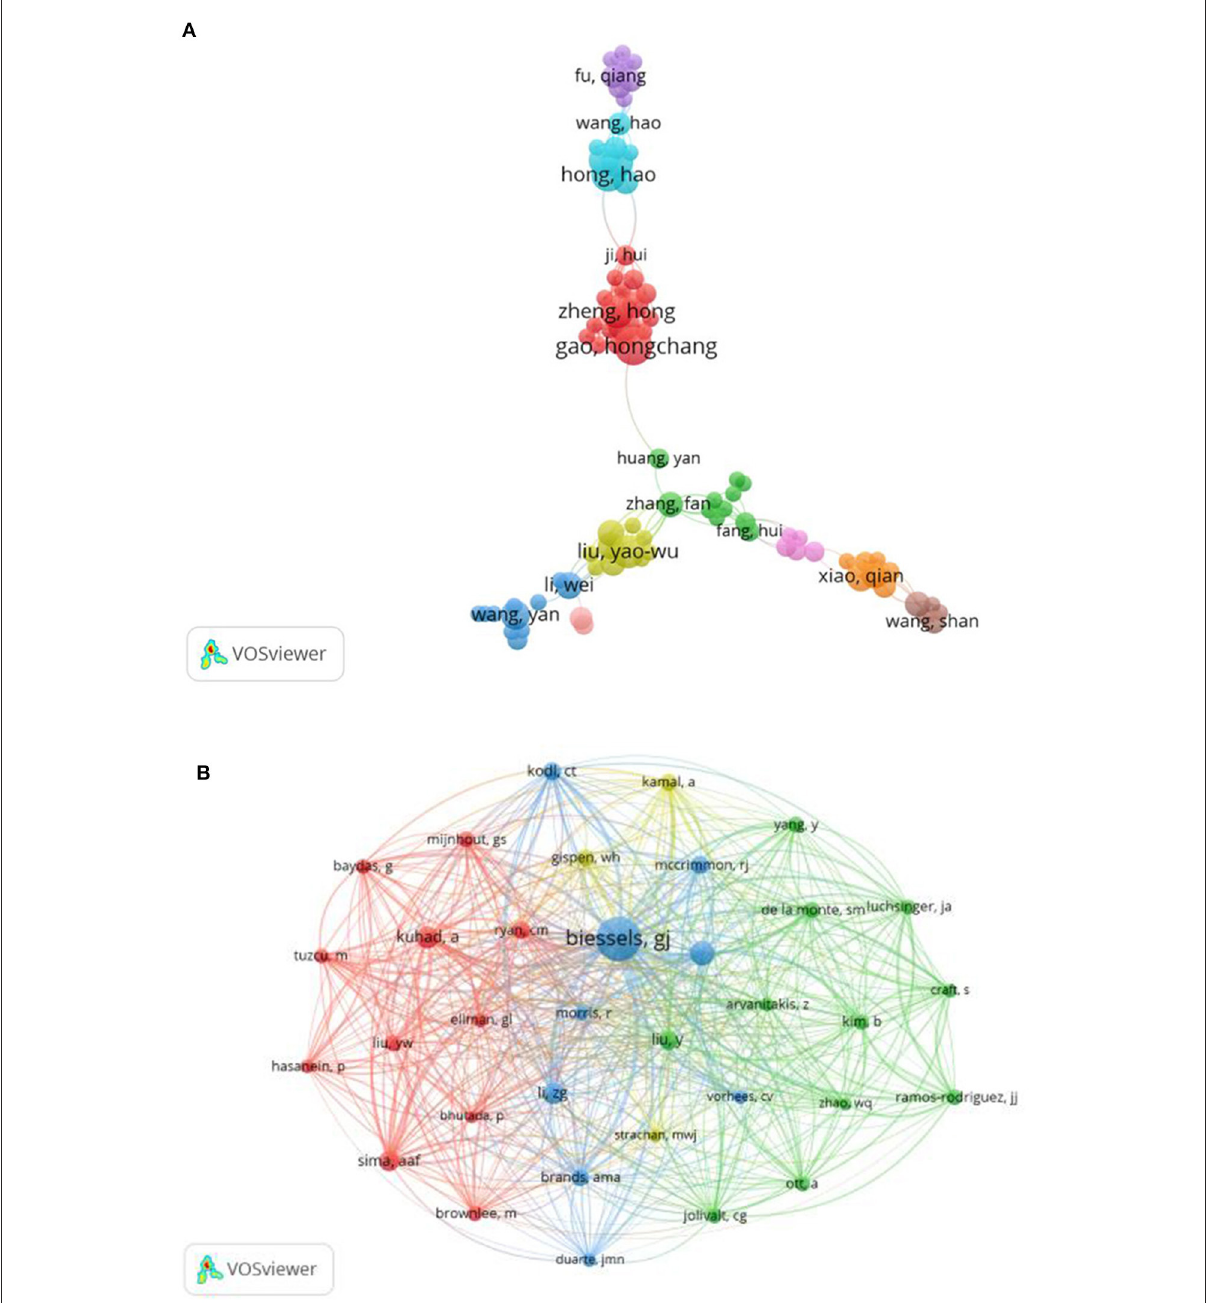
FIGURE3 (A) The network visualization of authors collaboration. (B) The network visualization of co-cited authors with the minimum citations over 40 times.